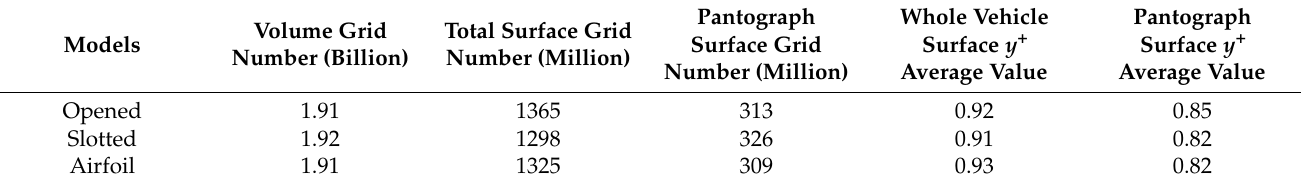
Figure 3. Schematic diagram of the calculation grid. Table 3. Table of calculation grid parameters.